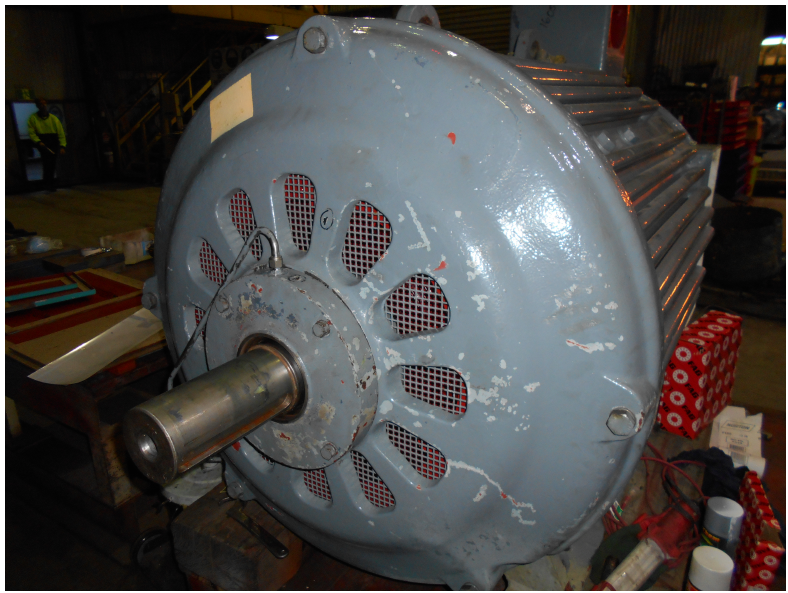
Figure 1. Open Drip Proof (ODP)